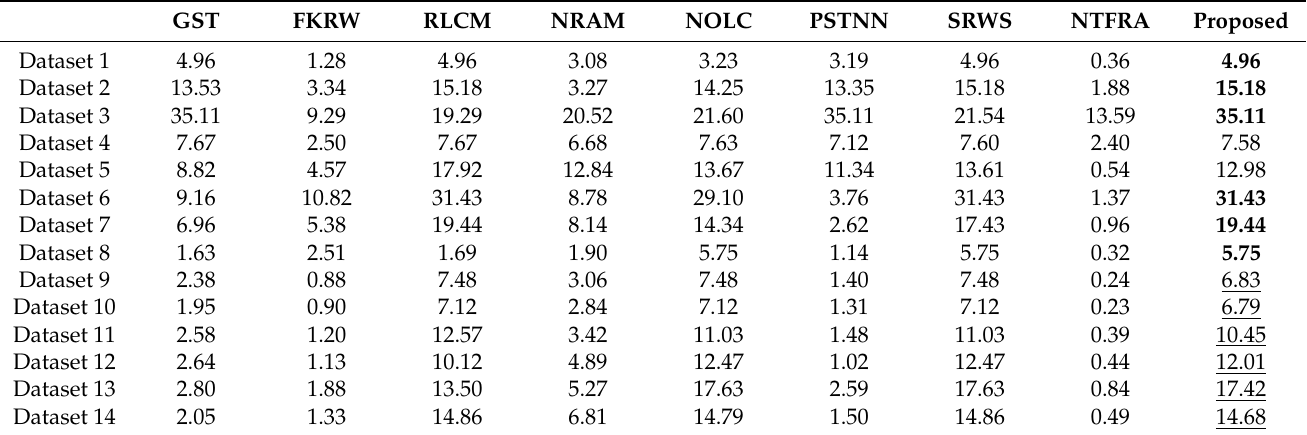
Table 7. Comparison of average BSF between the proposed method and 8 traditional baseline methods in 14 sequence scenes.